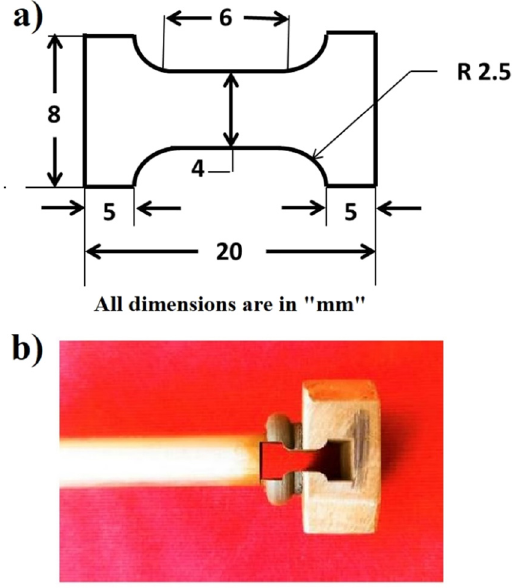
Figure 7: ( a ) Miniature tensile specimen dimensions and ( b ) spe - cimen